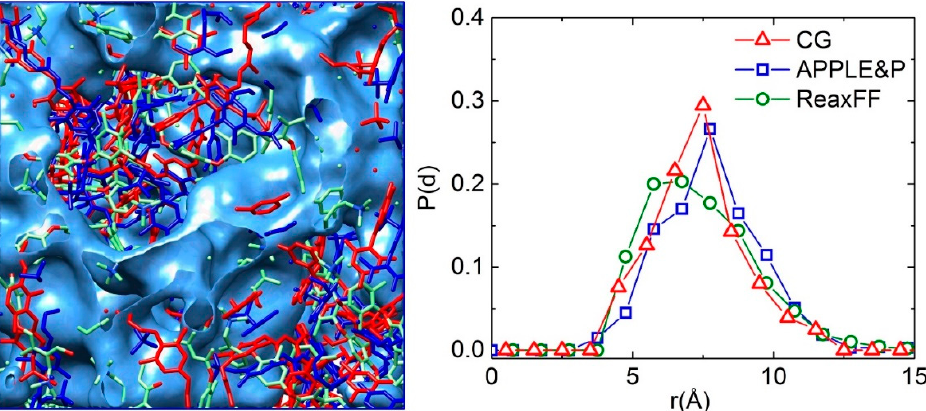
Figure 3. Left panel: Snapshot of morphology of hydrated membrane (red for polymer phase using coarse grained (CG) model; blue for polymer phase using APPLE&P, green for polymer phase from ReaxFF model; blue isosurface of water channels are drawn at 50% of bulk water density). Right panel: Distribution of water channel sizes from different models.